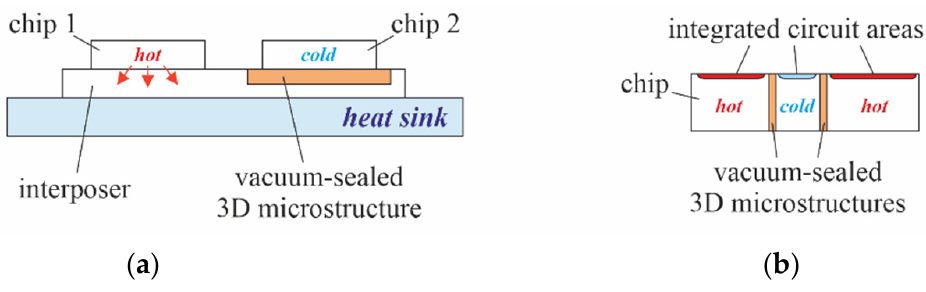
Figure 14. ( a ) Interposer substrate with integrated PowderMEMS structure on top of a heatsink for thermal isolation of chips, which are in close proximity. ( b ) Semiconductor substrate with PowderMEMS structures spanning its full height, creating thermally and electrically isolated islands within an integrated circuit.